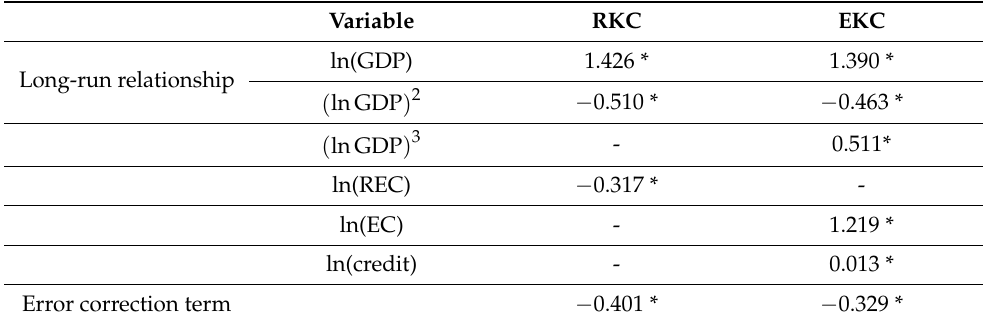
Table 7. Pool mean groups (PMG) regressions to explain the GHG emissions in V4 countries, Bulgaria and Romania (EKC and RKC) in basic model. Variable RKC EKC Long-run